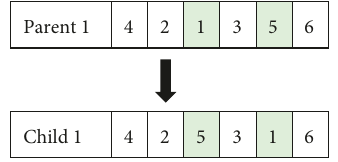
Figure 5: GA mutation operation.